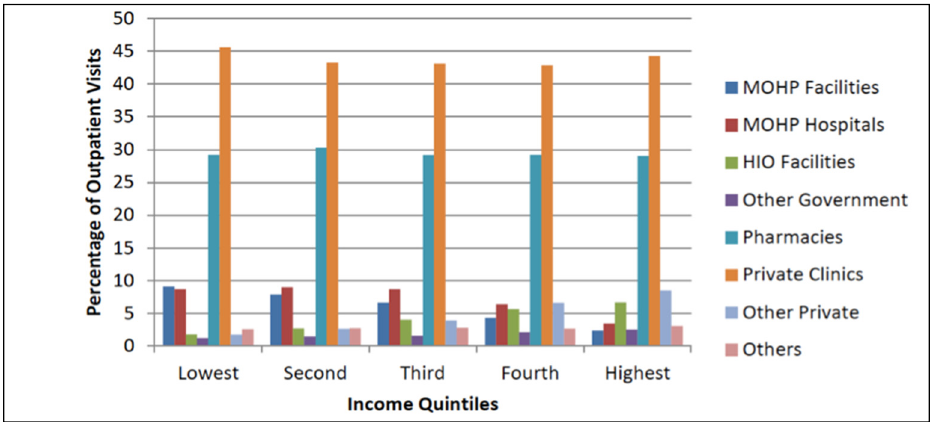
Figure 2. Choice of outpatient care provider by income quintile. Source: Egypt National Health Accounts